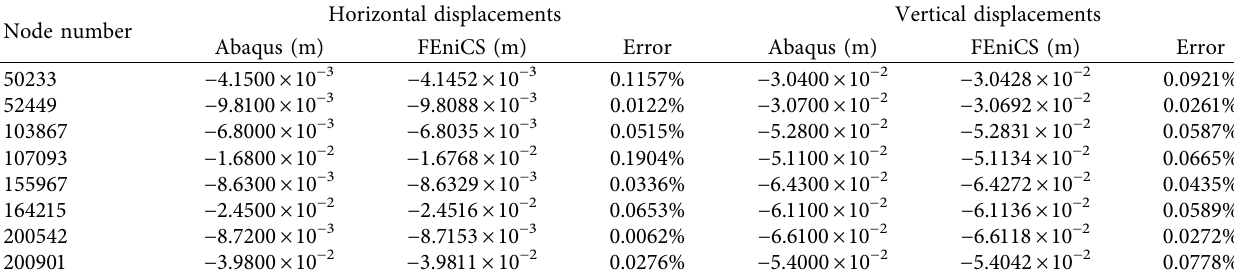
Table 1: The displacement in given node got by reduced order model and full order model.